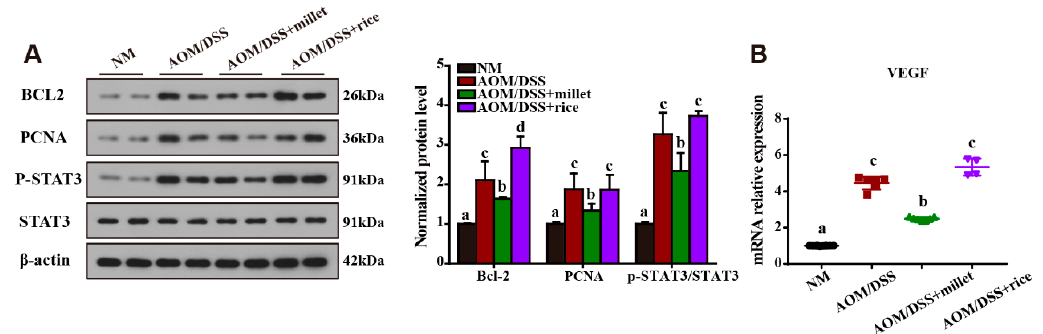
Figure 5. ( A ) Western blotting of B-cell lymphoma-2 (Bcl-2), proliferating cell nuclear antigen (PCNA), P-STAT3, and signal transducer and activator of transcription 3 (STAT3) in the colonic samples. ( B ) mRNA expression of vascular endothelial growth factor (VEGF) in the colon. Data are shown as the mean ± SD. Means with different letters are significantly different ( p < 0.05). n = 10, 6, 7, and 4 for NM, AOM/DSS, AOM/DSS + millet, and AOM/DSS + rice groups, respectively.